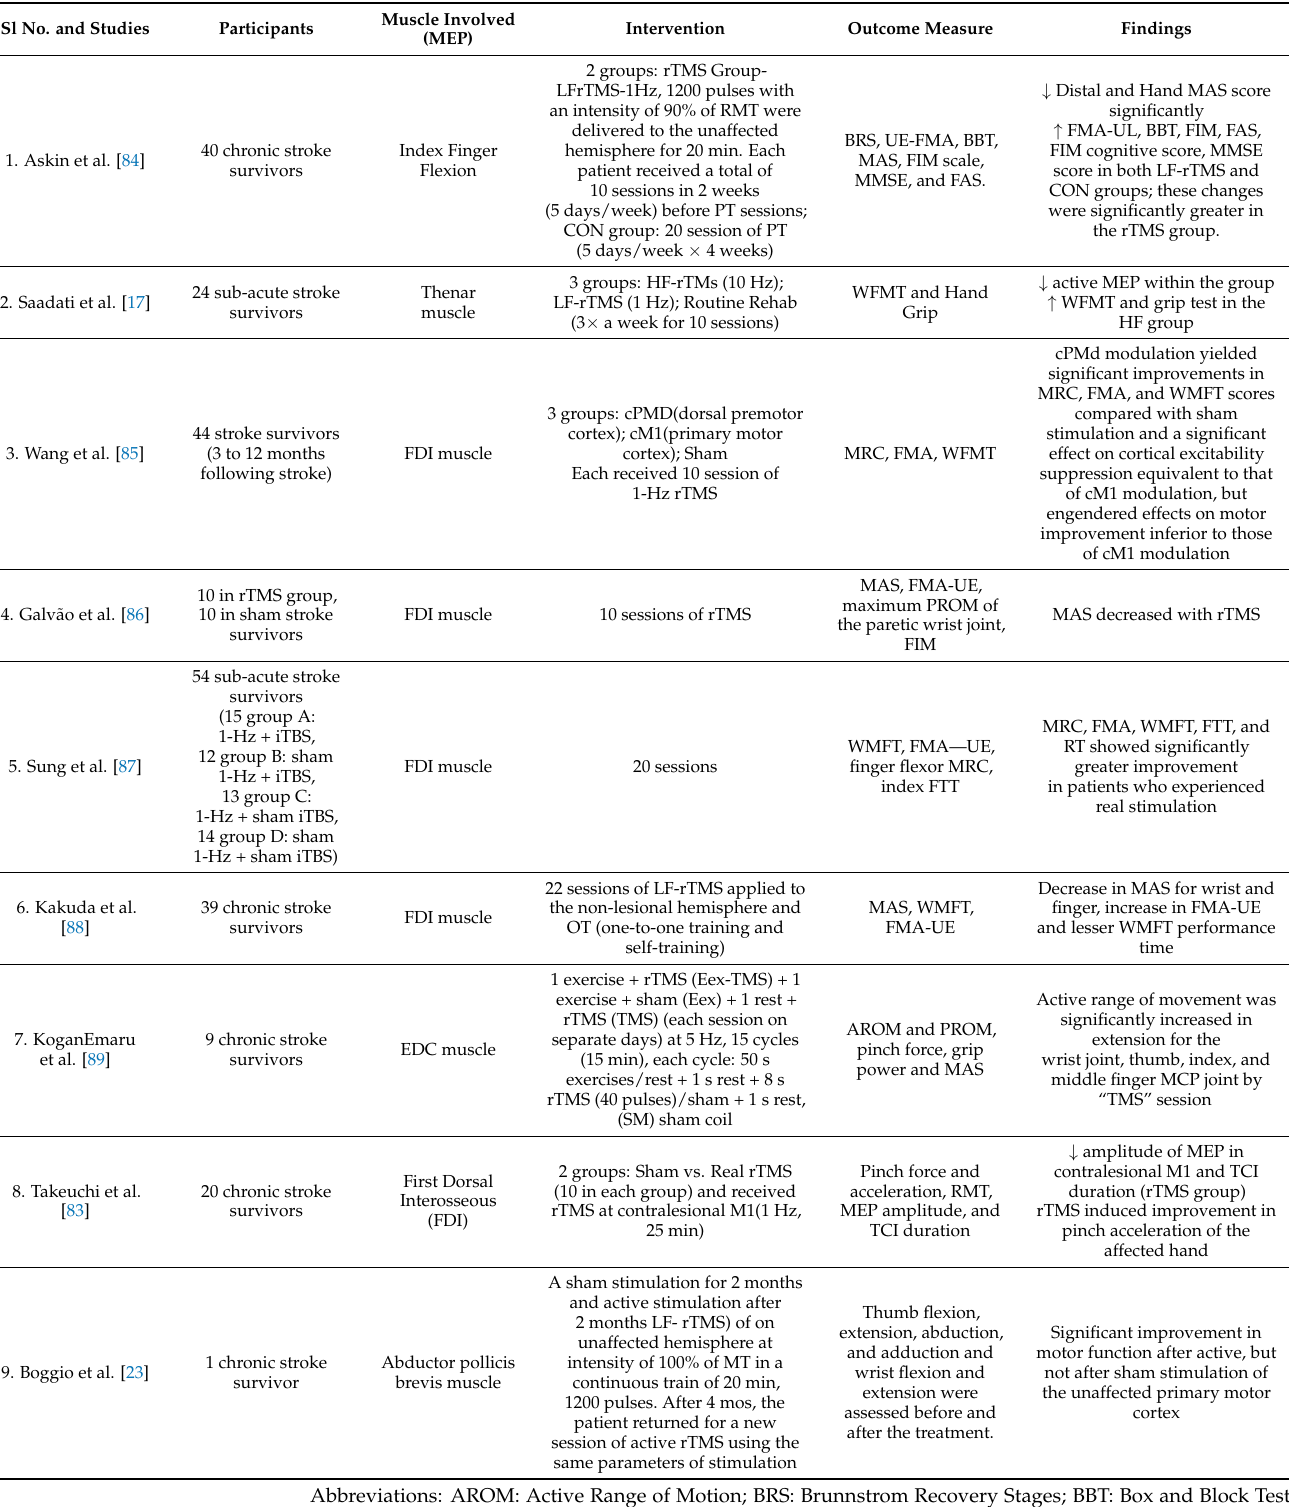
Table 2. rTMS-based studies primarily focusing on distal upper